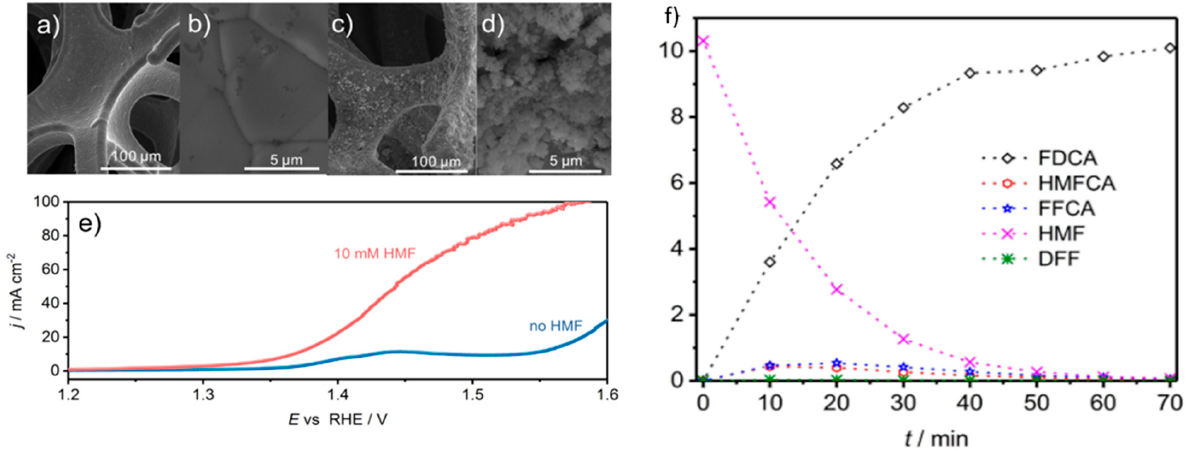
Figure 12. ( a , b ) SEM images of nickel foam before CoB deposition. ( c , d ) SEM of foam after CoB deposition. ( e ) LSV in flow reactor with and without 5-HMF. ( f ) Concentration against time for various products. Reprinted with permission from Ref [67]. Copyright 2018, Beilstein Journal of Organic Chemistry.